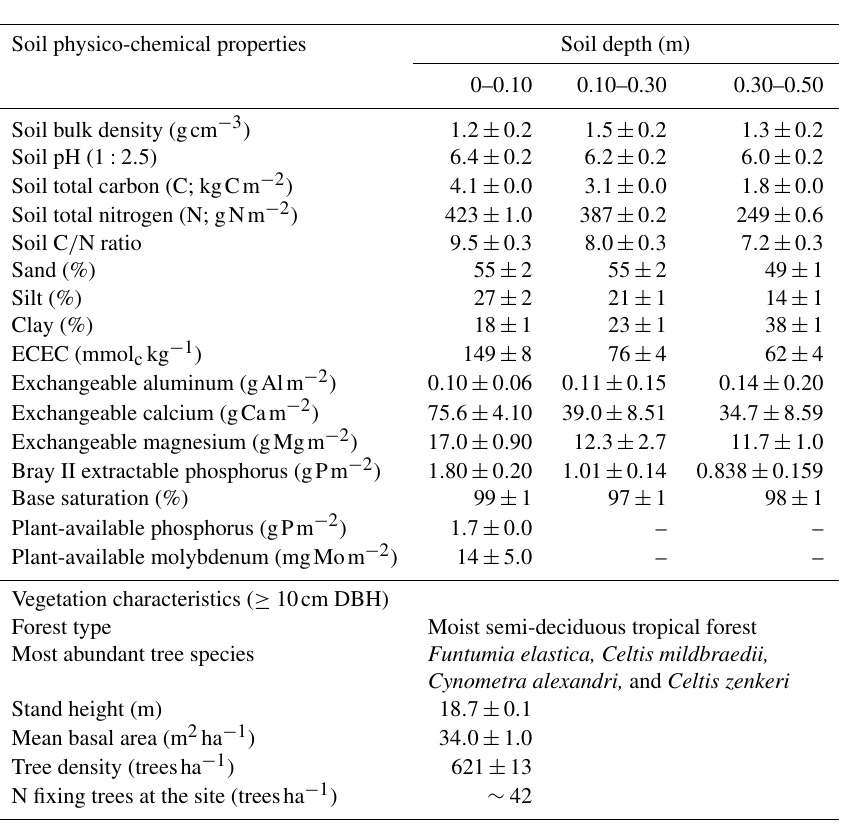
Table 1. Soil physico-chemical properties in three depths and vegetation characteristics of the study site located in the Budongo Central Forest Reserve, northwestern Uganda.